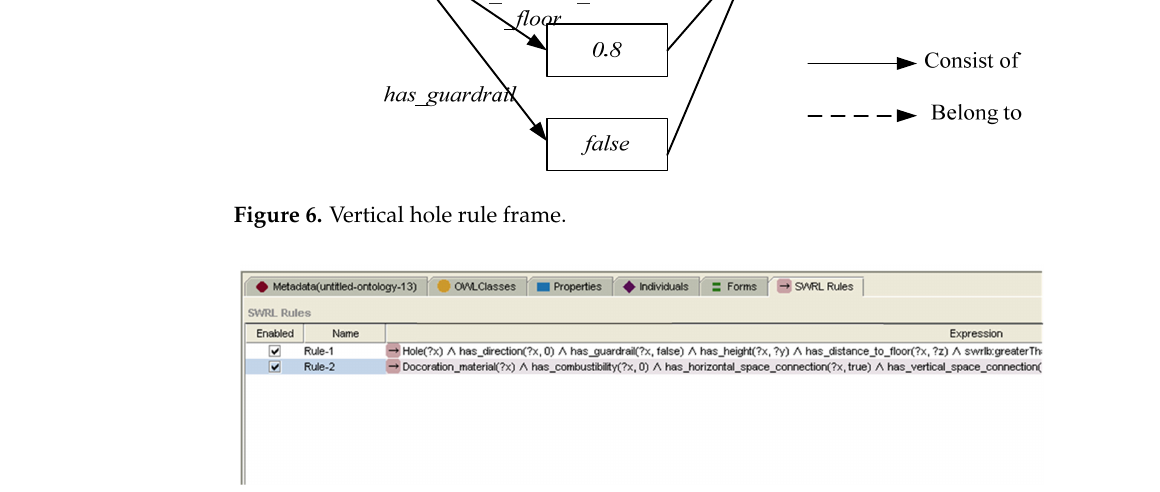
Figure 7. Vertical hole and cutting fire instance rules.